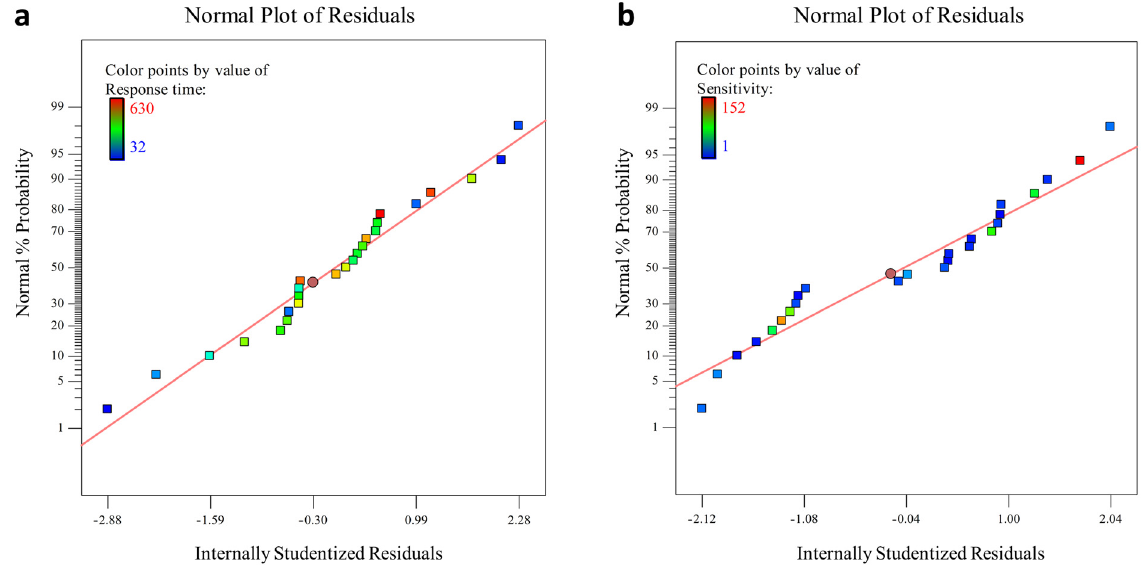
Figure 3. System’s response around the normal diagrams: ( a ) Response Time and ( b ) Sensitivity.